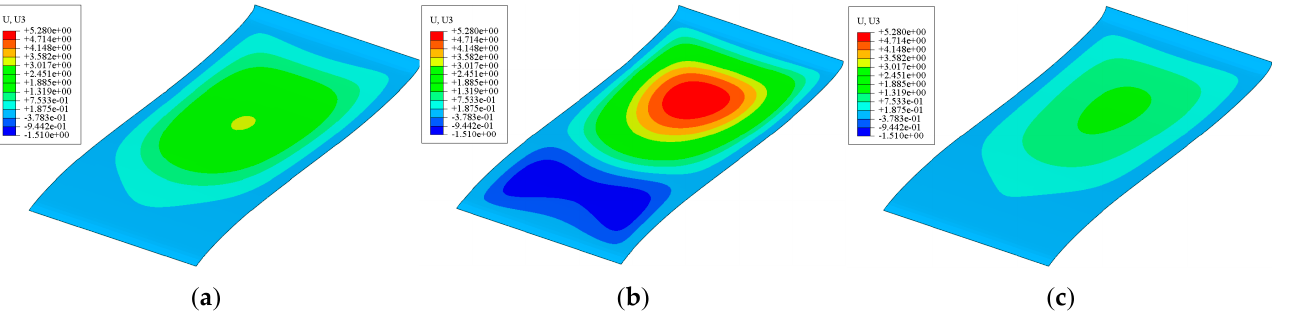
Figure 28. Lower surface deformation under different prestress: ( a ) P s = 0.017 MPa, P c = 0.017 Mpa; ( b ) P s = 0.017 MPa, P c = 0.051 Mpa; ( c ) P s = 0.051 MPa, P c = 0.017 Mpa.